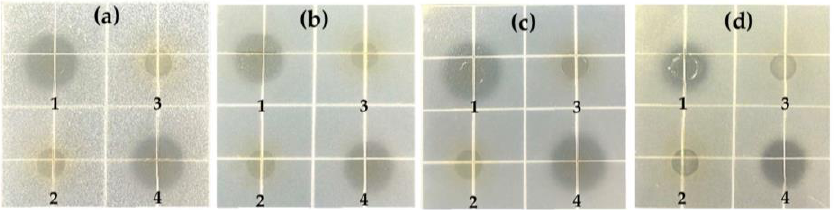
Figure 2. Antibacterial result of Loigolactobacillus coryniformis NA-3 supernatant evaluated by Ox- ford cup test. ( a ) B. cereus. ( b ) S. Typhimurium. ( c ) E. coli O157:H7. ( d ) S. aureus. 1: Original super- natant of L. coryniformis NA-3 (pH 4.0). 2: Supernatant of L. coryniformis NA-3 with pH adjusted to